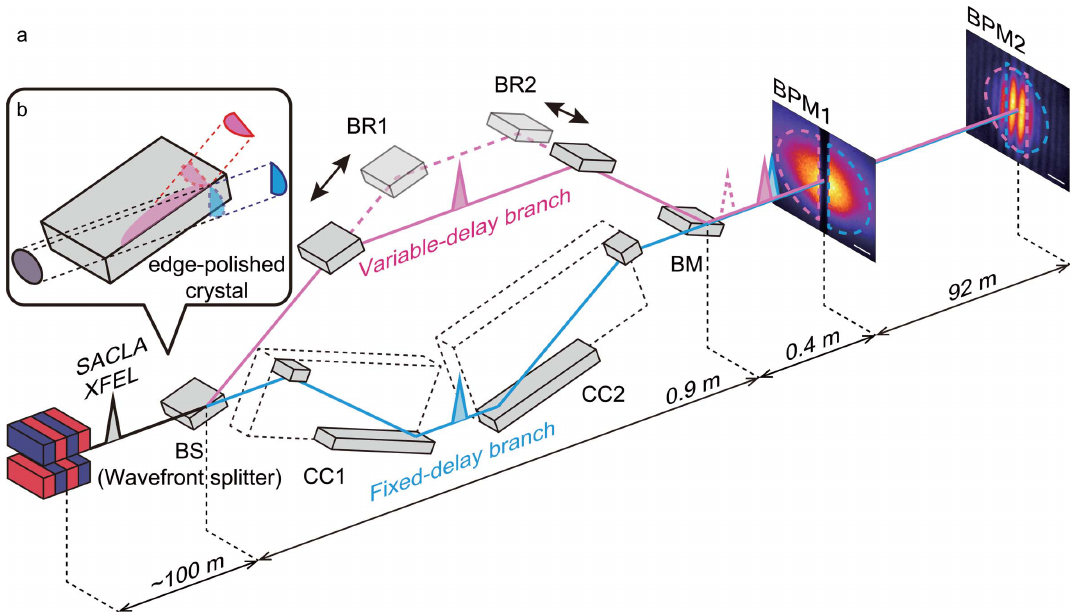
Figure 1 ( a ) Schematic diagram of the experimental setup with a separate six-crystal interferometer. Awavefront of a 10 keV XFEL pulse propagating through an Si(111) double-crystal monochromator (not displayed) is split into two parts by an edge-polished crystal beam splitter (BS). A conceptual sketch of the wavefront division is depicted in panel ( b ). The transmission part (blue, lower path) propagates in the fixed-delay branch through fourfold Bragg-case reflections at a set of two channel-cut crystals (CCs). The other, reflection, part (red, upper path) is reflected three more times by two movable beam reflectors (BRs) and a beam merger (BM), and recombines with the transmission part at the BM in the variable-delay branch. By introducing an angular deviation between the two beams, the two initially spatially separated split X-ray pulses are superimposed at an imaging detector (BPM2) and form interference fringes with a near-zero delay. Another imaging detector (BPM1) is used to align the optical elements in the variable-delay